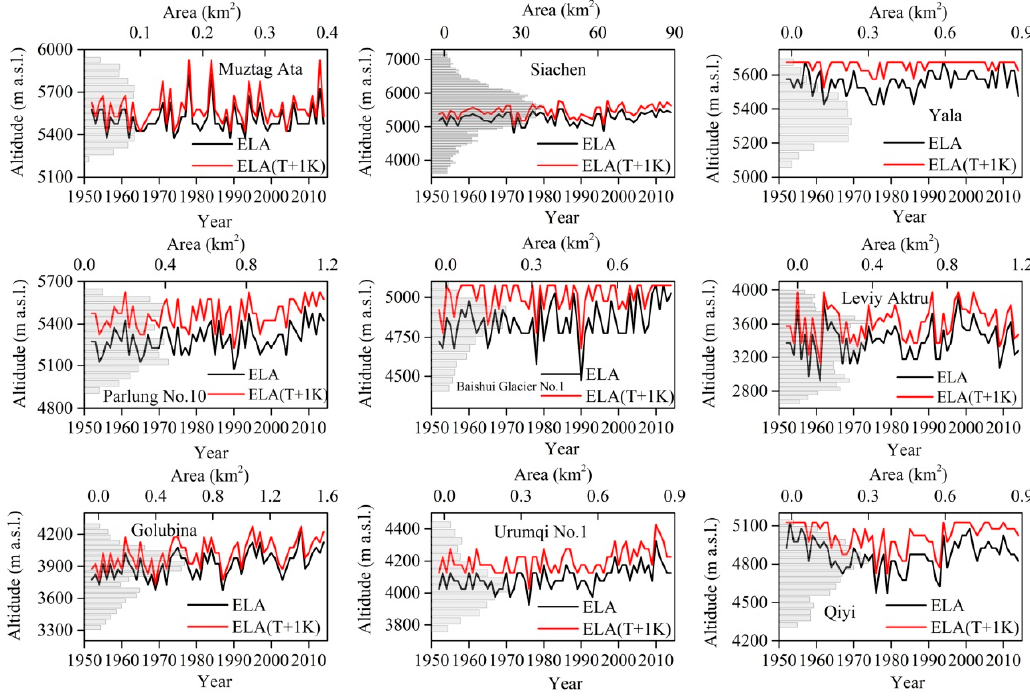
Figure 6. Sensitivity of ELA to temperature change of +1 K.